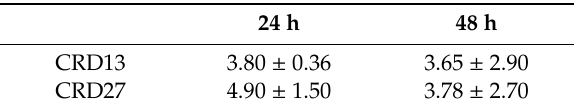
Table 1. Inhibitor concentrations (IC 50 ± SD ( µ mol / L)) resulting in 50% dendrimer-mediated reduction of 1301 cell